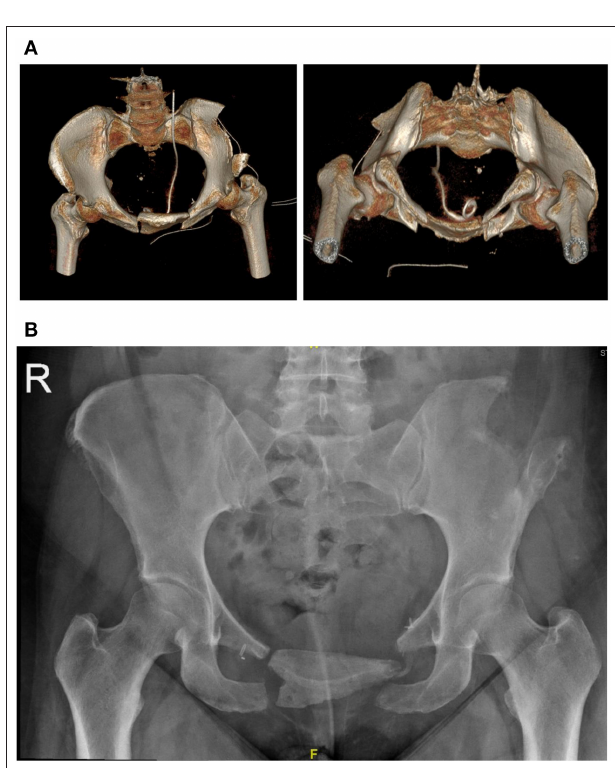
FIGURE 4 | (A) day 1 post surgery. 3D reconstructions of a CT pelvis demonstrating the iliac crest graft in-situ . (B) 6-month follow up X-Ray demonstrating stable positioning of the